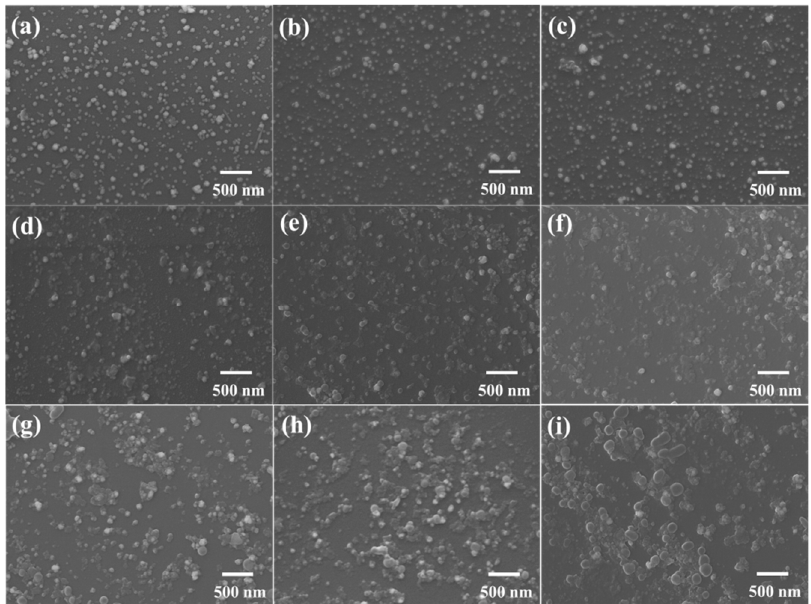
Figure 1. SEM images of ( a ) Ag NPs and ( b – i ) Ag/4-MBA/PEDOT:PSS (the concentrations were 0.05%, 0.075%, 0.1%, 0.2%, 0.3%, 0.5%, 0.8%, and 1.0%).